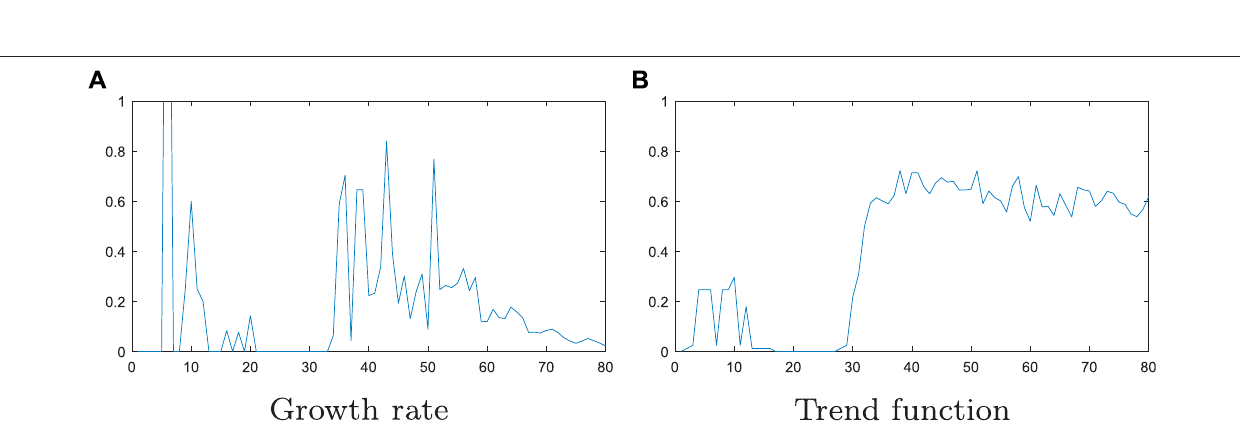
FIGURE 2 | Networks at the 43rd day of the four regions. The number of connections in the network re fl ects the change degree of nine-day growth rate.